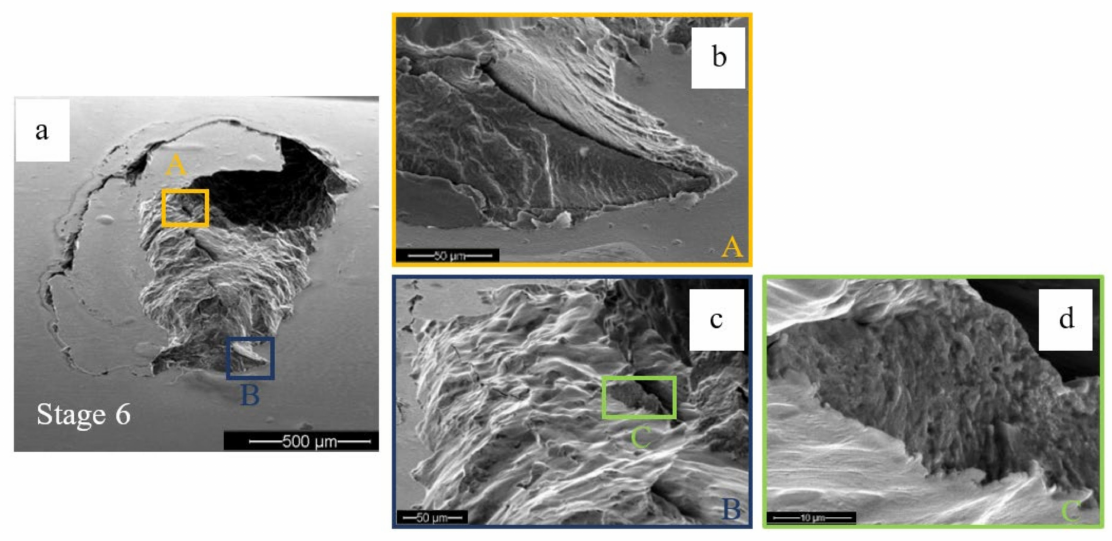
Figure 11. Two suspected areas, “A” and “B” with periodic marks were observed. ( a ) The final stage of the disassembly and reassembly test. ( b ) Close-up image of the periodic marks in area “A”, ( c ) Close-up of area “B”, and ( d ) of periodic marks in area